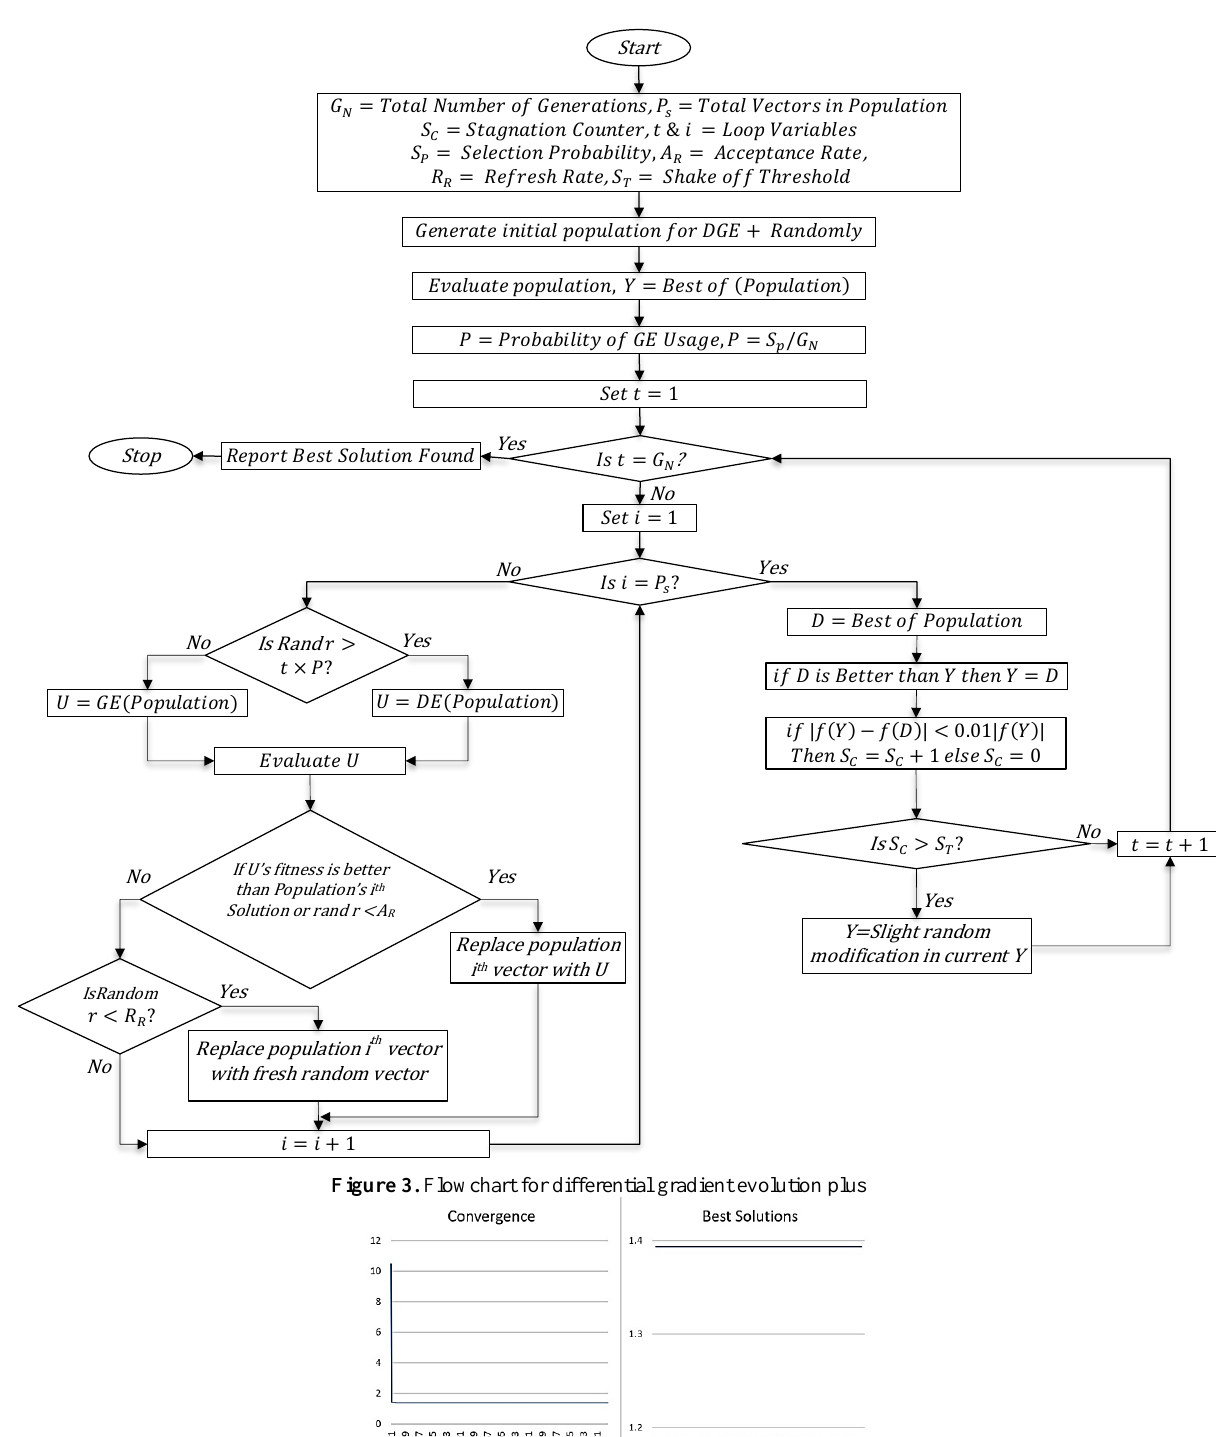
Figure 4. Convergence curve and 30 best solutions for constraint problem